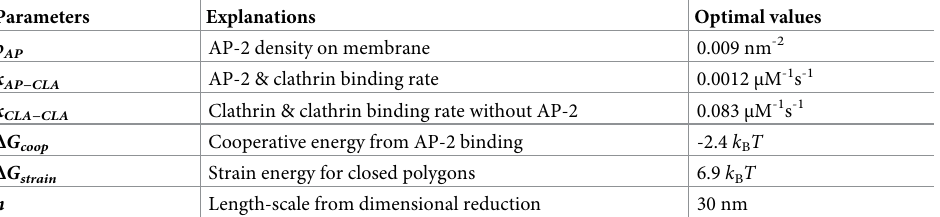
Table 1. Each parameter varied in the RD model to reproduce in vitro experimental kinetics, along with the opti- mal values we found. Other energies, geometries, and concentrations were fixed by experimental data. Parameters Explanations Optimal values ρ AP AP-2 density on